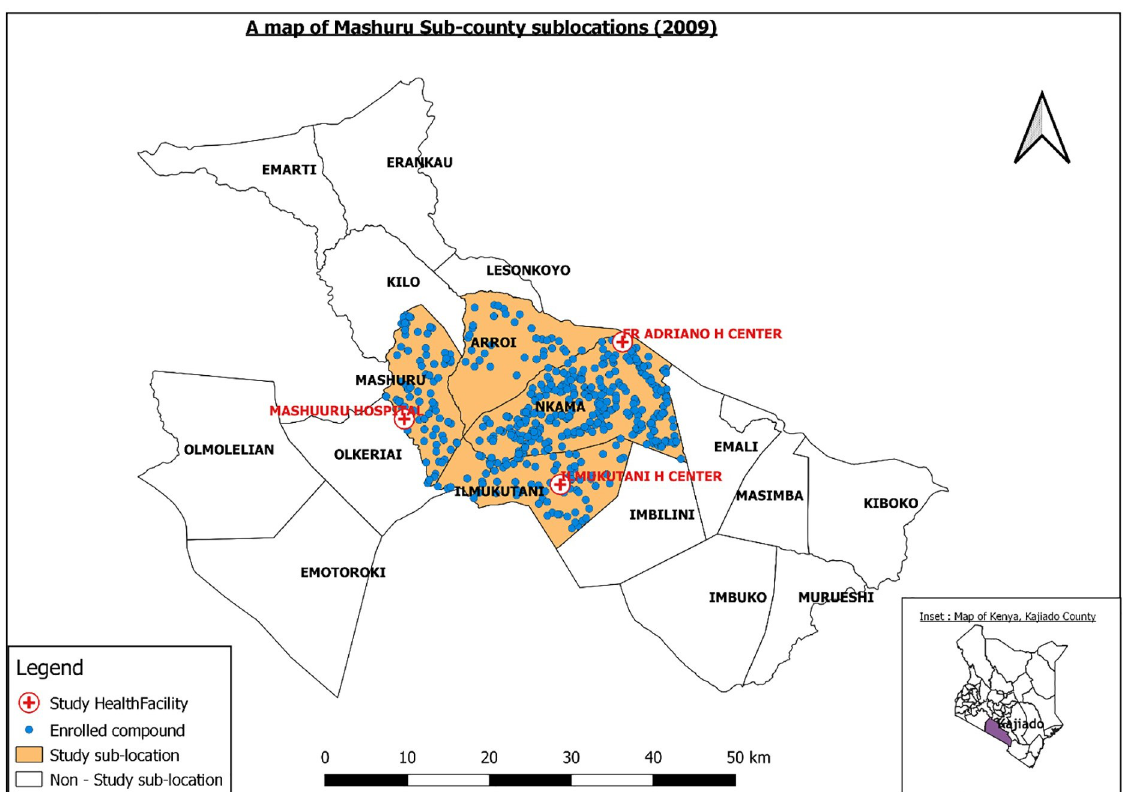
Fig 1. Map of Mashuru sub-county showing the study sublocations and enrolled households. Inset is a map of Kenya showing Kajiado